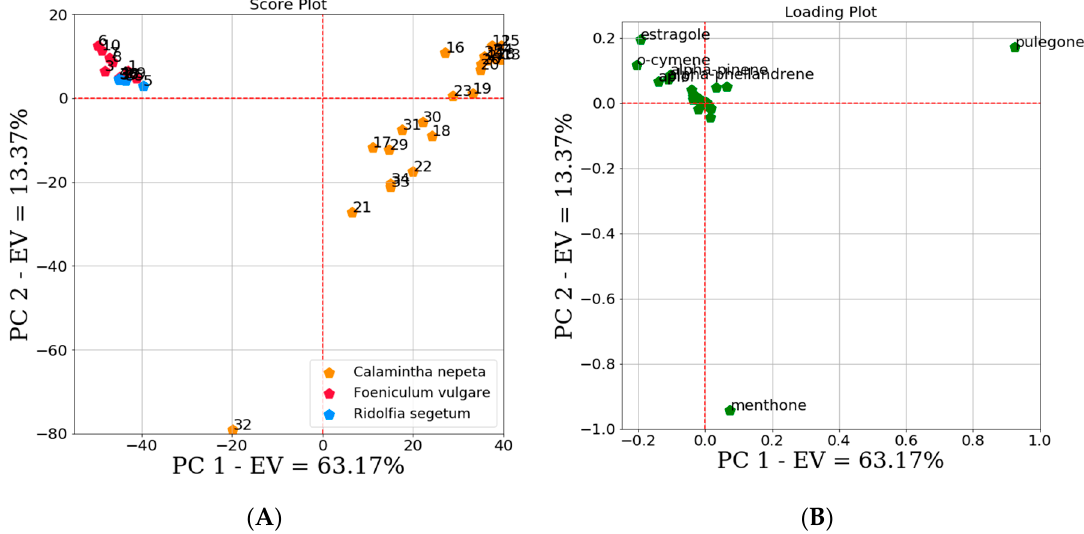
Figure 3. Scores ( A ) and loadings ( B ) plots of the first two principal components (PCs). EV indicates the explained variance. Score plot ( A ) showed the presence of two clusters, a first cluster indicated the Calamintha Nepeta (CNEO) samples, the second one Foeniculum vulgare (FVEO) and Ridolfia Segetum (RSEO) samples. In the plot sample 32 seems to be the outlier. The first two PCs in loading plot ( B ) highlight that estragole, o-cymene, alpha-pinene, alpha-phellandrene and pulegone could be the most important chemical constituents among all the tested EOs.